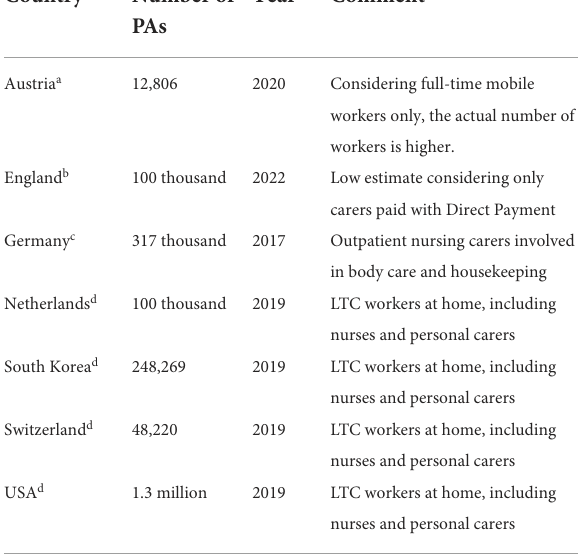
TABLE 1 Domestic care workers market